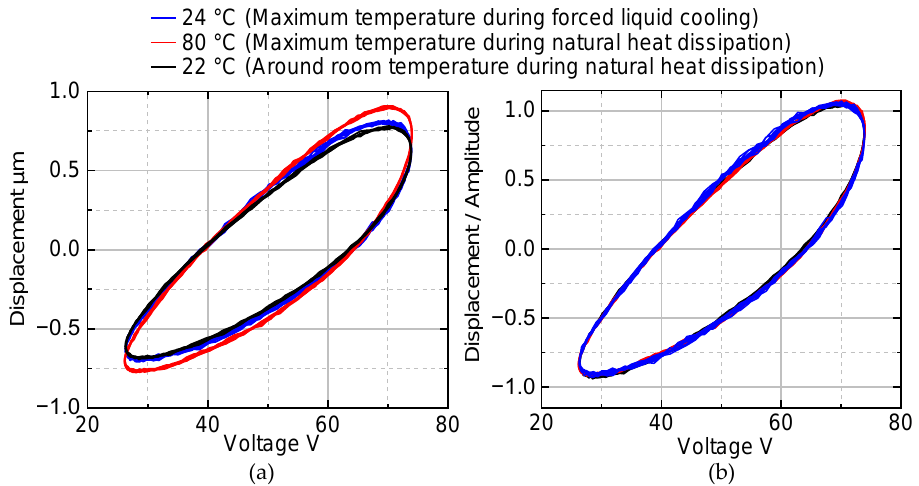
Figure 3. ( a ) Measured voltage displacement hysteresis curves with natural heat dissipation and liquid cooling and ( b ) the same curves normalized by amplitude. A bias voltage of 50 V and a sinusoidal voltage of 24 V at a frequency of 10 kHz were applied to the PESA.